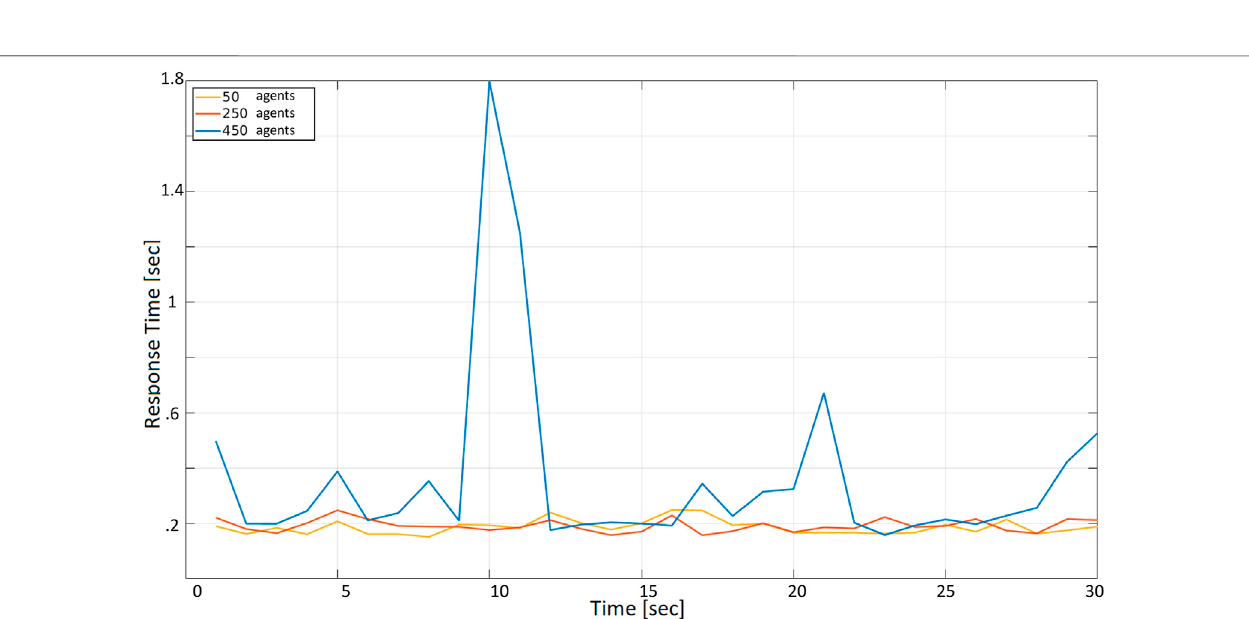
FIGURE 8 | Cloud response time with a request period r = 1 s with 50, 250, and 450